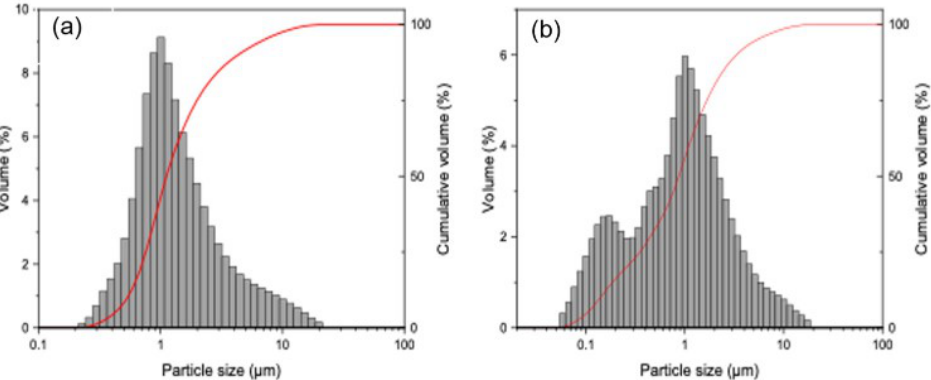
Table 2. Properties of different powders.